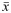
NR2A/2B subunit expression of the murine hippocampus at 7 and 12 weeks.Data are shown in x¯ ± MSE, differences between groups unpaired Mann Whitney U test, P < 0.05. A) Relative expression of NR2A and NR2B at 7 weeks. B) Relative expression of NR2A and NR2B at 12 weeks.